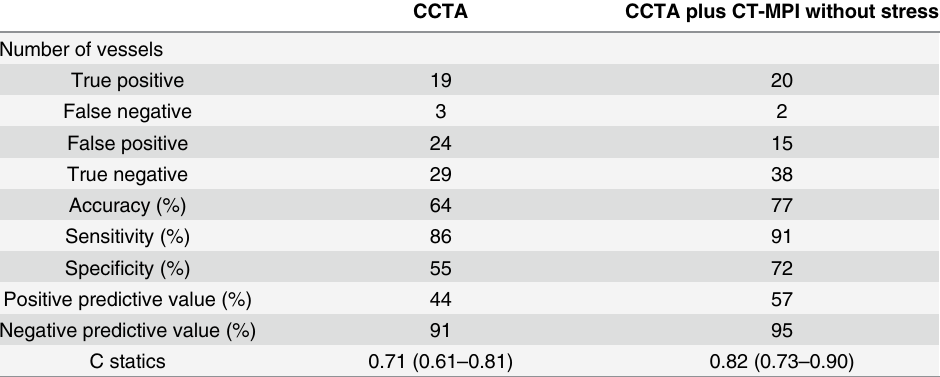
Table 2. Diagnostic accuracy of CCTA and CCTA plus CT-MPI without stress for detection of signifi- cantly stenotic coronary arteries in 75